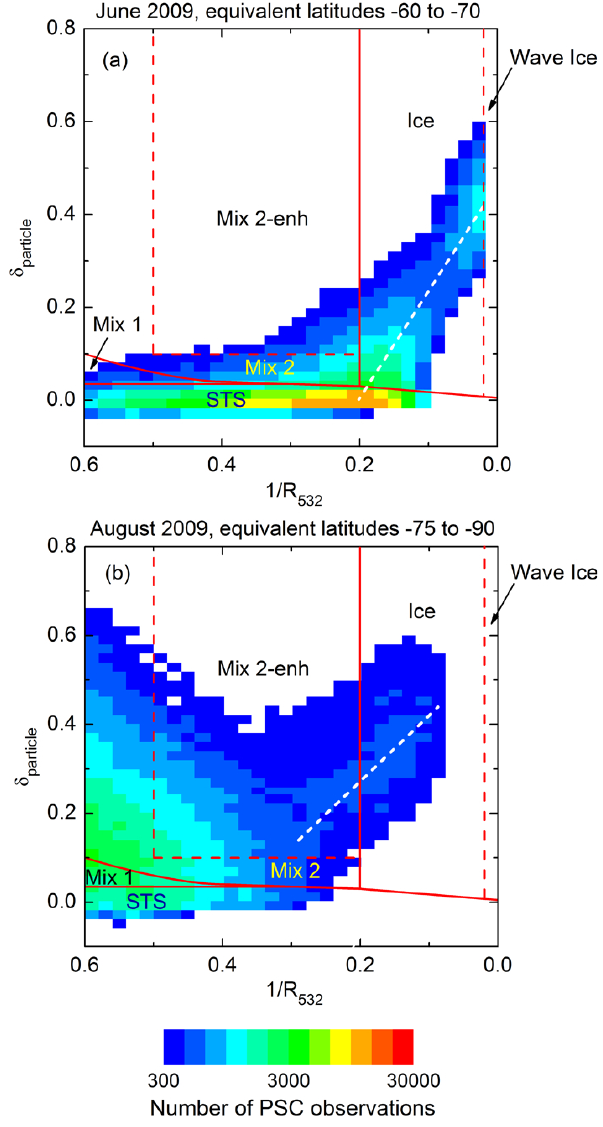
Fig. 11. Distribution of CALIOP PSC observations for (a) June and (b) August 2009 in selected equivalent latitude bands as indicated at the top of each panel. The colors represent the density of the PSC observations in each bin relative to the maximum. The white dashed lines indicate the axis of the ice PSC observations. The bin size is 0 . 02 × 0 . 02 (both